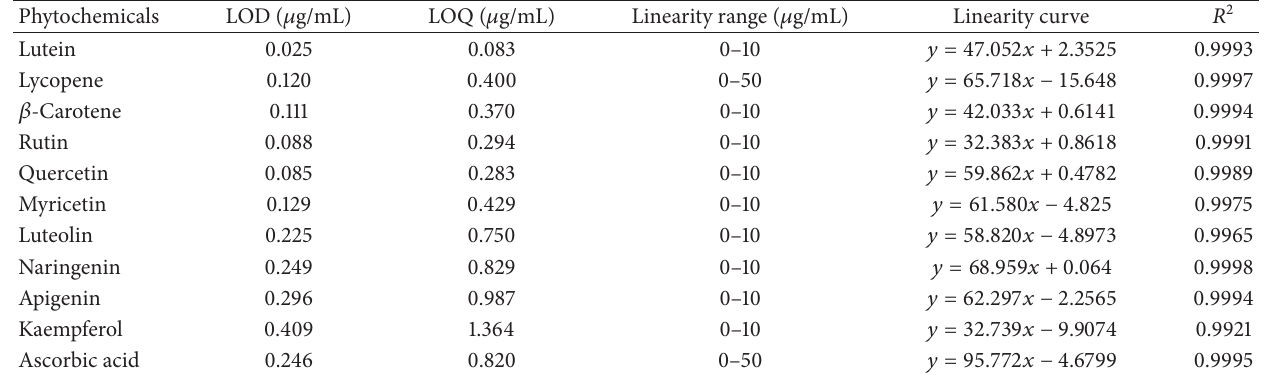
Table 1: Parameters for the HPLC determinations of carotenoids, flavonoids, and ascorbic